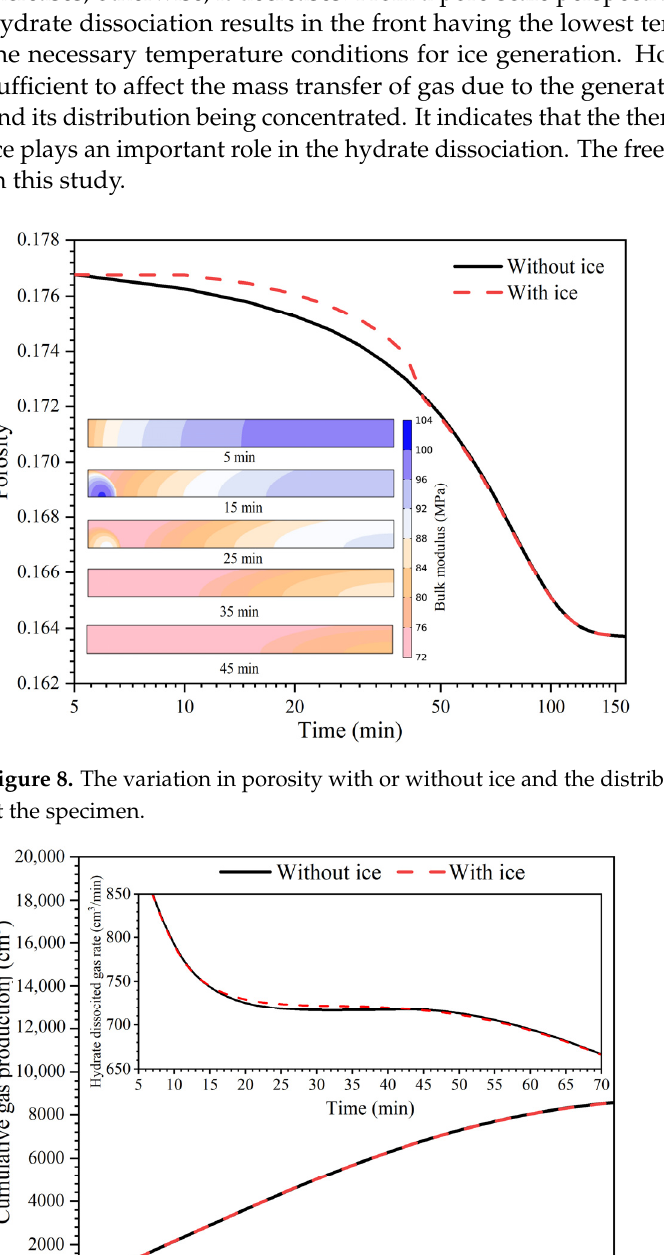
Figure 10. Water production rate with or without ice. 4. Conclusions In this study, a fully coupled thermo-hydro-mechanical-chemical (THMC) model for methane HBS considering the effect of ice is established. The water–ice phase change equation and latent heat, thermally induced cryogenic suction, permeability, bulk and shear module of ice-HBS and hydration reaction specific area are considered. Masuda’s model is used to verify our coupled model; the temperature, pressure and cumulative gas production match well with experiment results. In order to qualitatively study the presence of ice on the effect of hydrate production, the lower outlet pressure is set. The ice generation is observed at the center of specimen adjacent outlet boundary according to the temperature variation. The ice generation re- duces the intrinsic permeability and fluid velocity significantly. The porosity decreases with hydrate dissociation, but the porosity of specimen with ice is higher than without